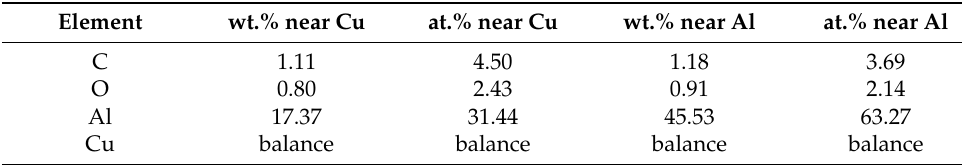
Figure 2. The X-ray diffraction patterns and the identified phases of the Al–Cu interface at two different locations: ( a ) Cu side and ( b ) Al side. Table 1. The element composition in weight percentage (wt. %) and atom percentage (at. %) of the locations highlighted in Figure